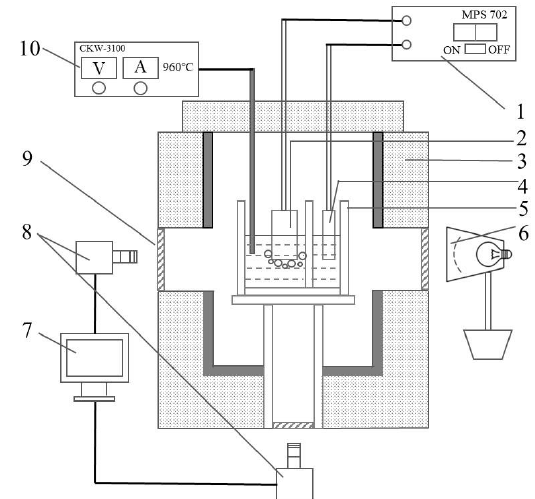
Figure 1. Schematic diagrams of the transparent electrolysis cell. 1: DC power supply; 2: anode; 3: furnace; 4: cathode; 5: quartz crucible; 6: light source; 7: computer; 8: industrial cameras; 9: quartz window; 10: CKW-3100 temperature controller.